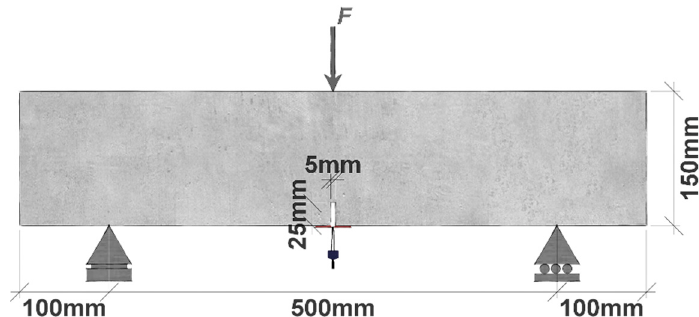
Figure 2. Setup for the notched three-point bending test according to BS EN 14651:2005.